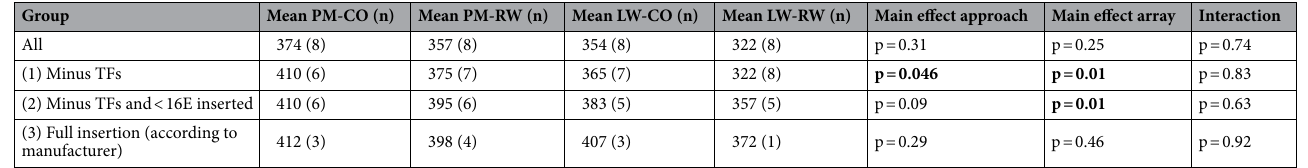
Table 2. Insertion depth angles. Significant values are in bold. TF tip fold-over, PM perimodiolar, LW lateral wall, CO cochleostomy, RW round window, E electrode-contacts.